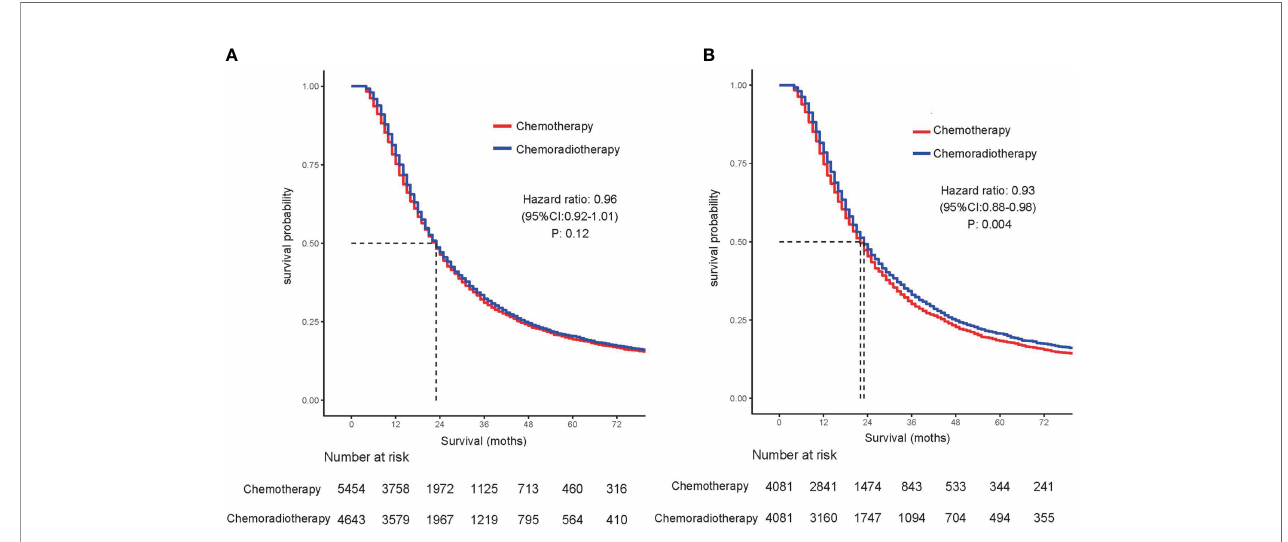
FIGURE 1 | Comparison of overall survival for patients treated with chemotherapy alone and patients treated with chemoradiotherapy in (A) unmatched and (B) propensity score – matched analyses.